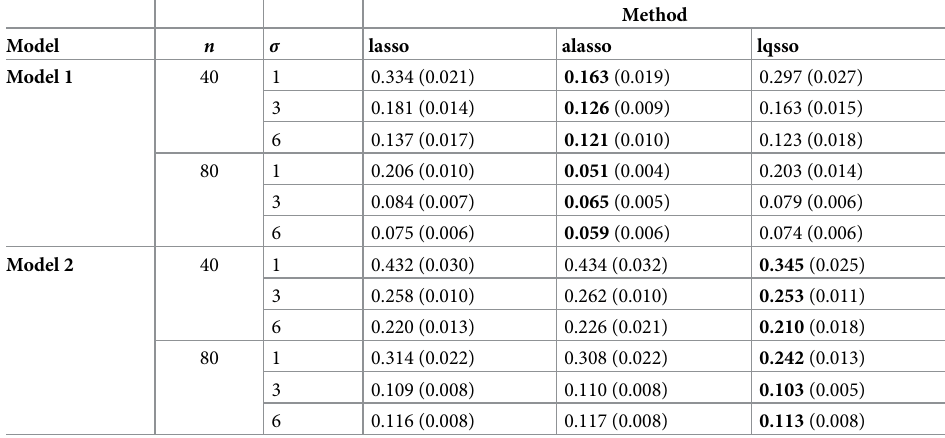
Table 1. The mean values of RPEs for Model 1 and Model